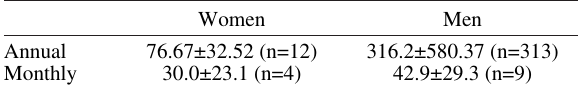
Table 5. – Estimated mean expenses of anglers (in €) by sex and type of licence (annual or monthly).